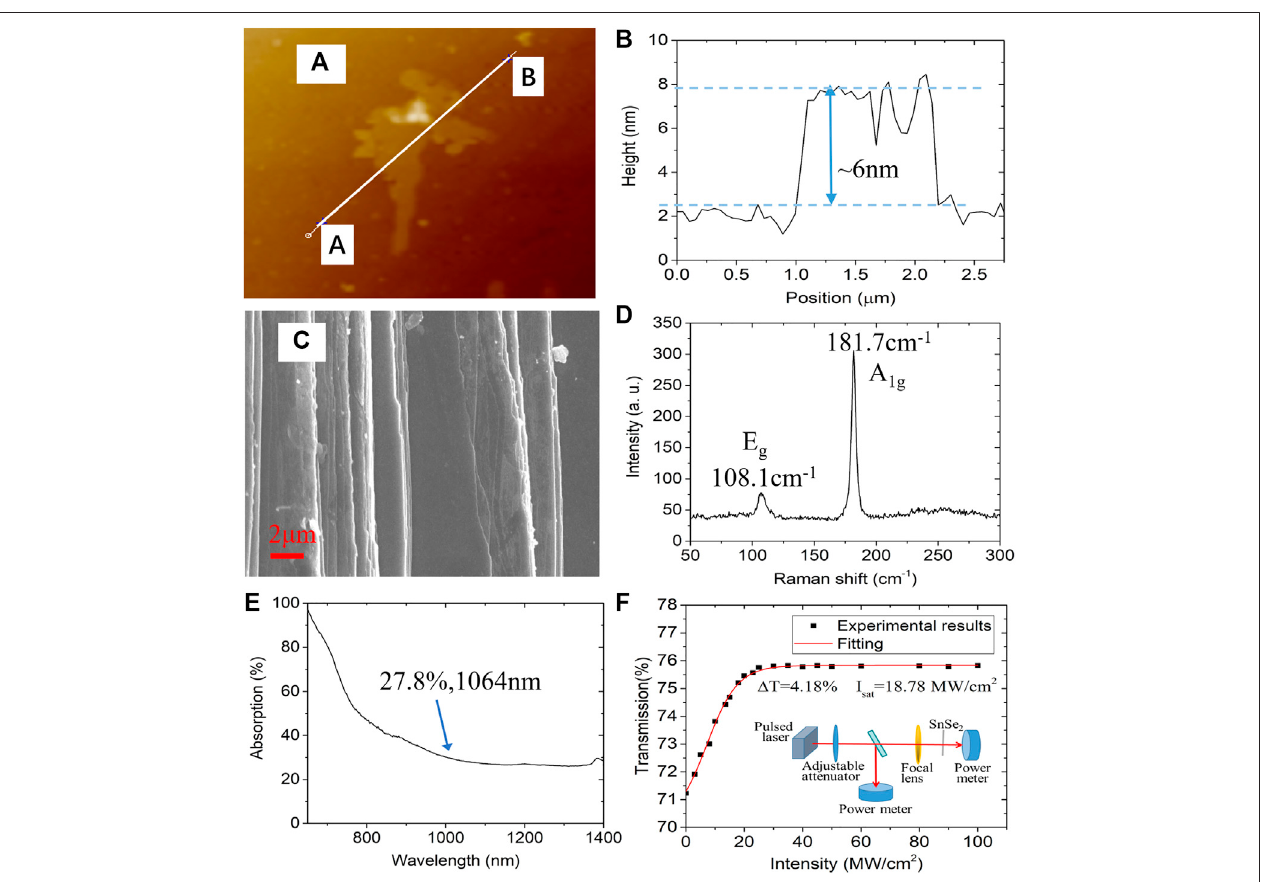
FIGURE1|(A) AFMimage; (B) thecorresponding heightsoftheAFMimage; (C) SEMimage; (D) Ramanspectrum; (E) AbsorptionspectrumoftheSnSe 2 fi lm; (F) Nonlinear transmittance curve of the SnSe 2